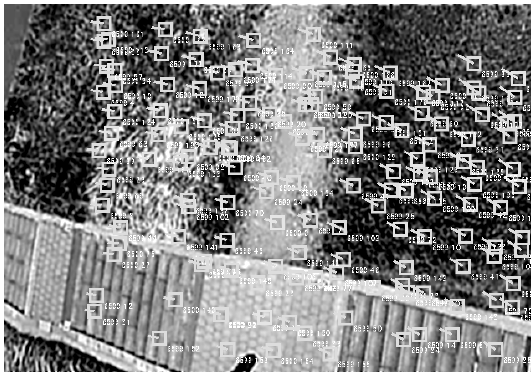
Figure 6. Example of OCM